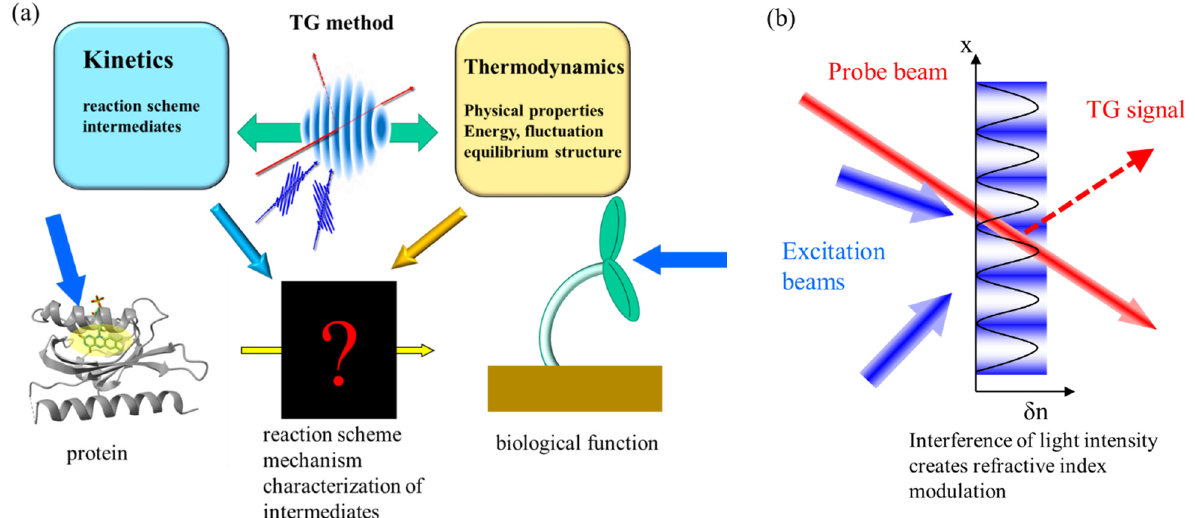
Figure 1. ( a ) Schematic illustration showing that the TG method can combine two important fields, kinetics and thermodynamics. Using this method, the reaction scheme, reaction mechanism, and characterization of short lived intermediates, which appear during protein reactions for biological functions, are elucidated. ( b ) Schematic illustration of the TG method. Two excitation beams create an interference pattern of light intensity, and this light produces spatially modulated refractive index change due to various origins. The refractive index change is probed by the diffraction of probe beam. Herein, our attempts to elucidate protein reaction kinetics and mechanisms by